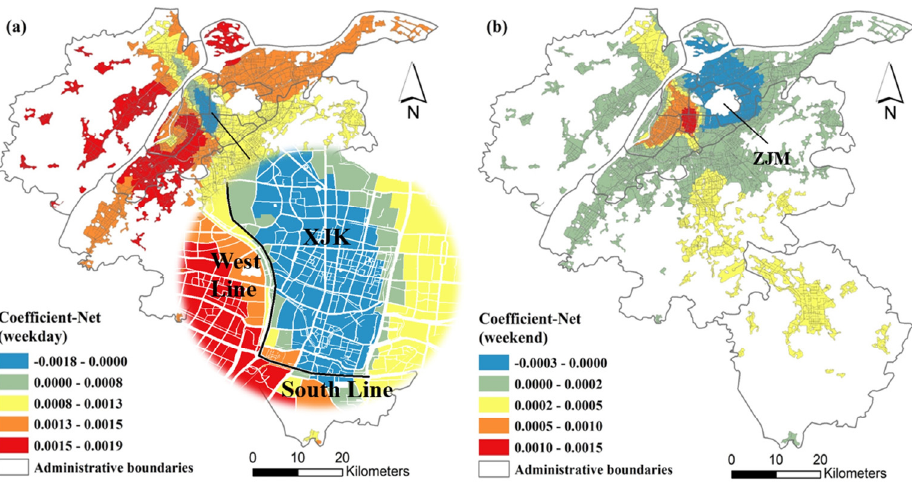
Figure 14. Net regression coefficients: ( a ) weekdays and ( b ) weekends.